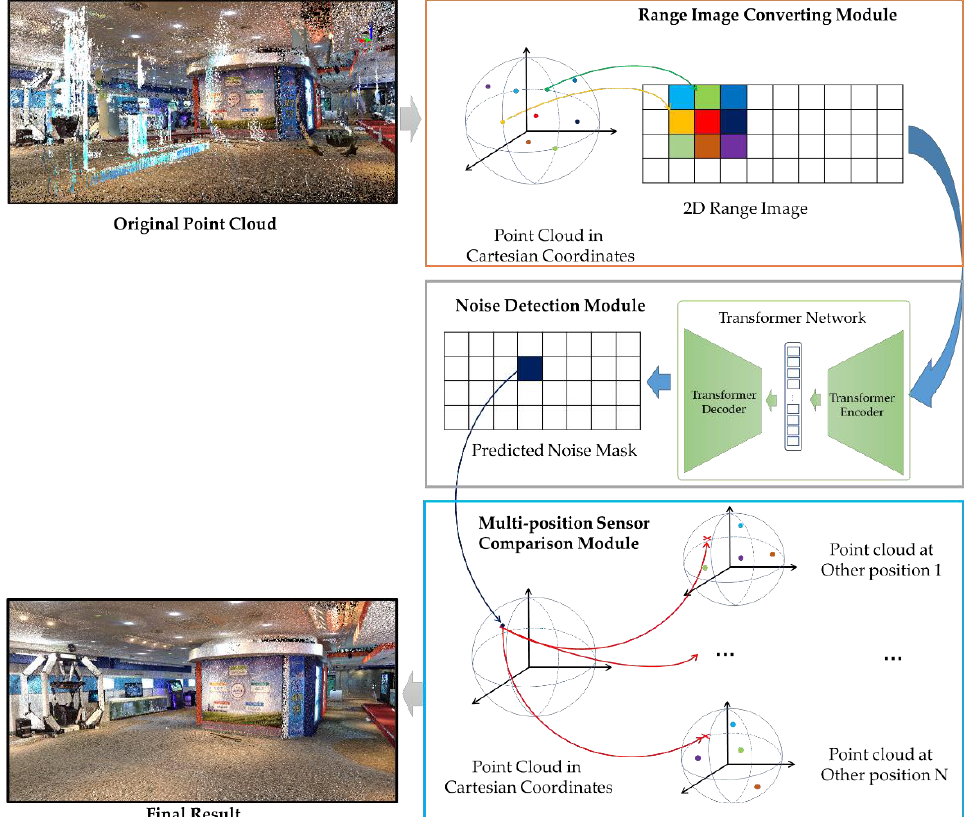
Figure 3. Overview of the proposed